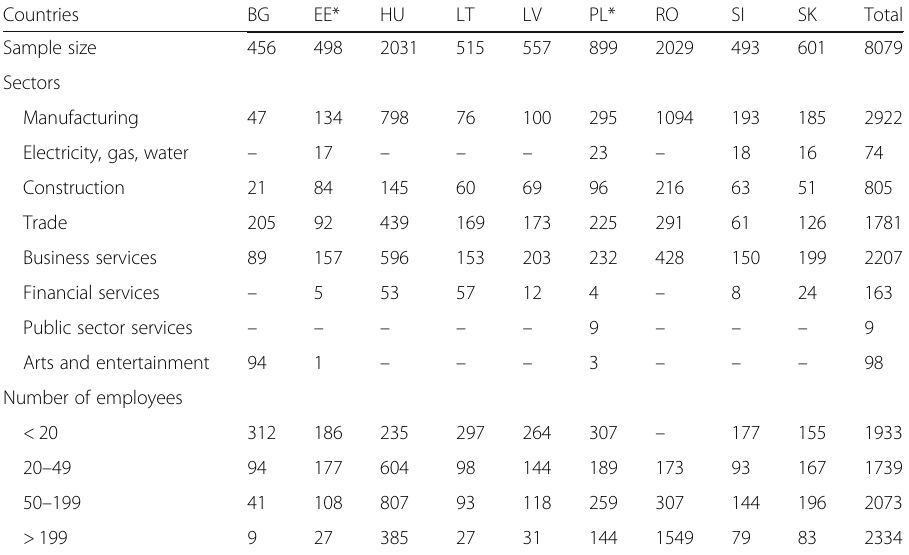
Table 1 Number of respondents by countries, sectors, and firm size (conditional on answers being given to the block of questions on the minimum wage) Countries